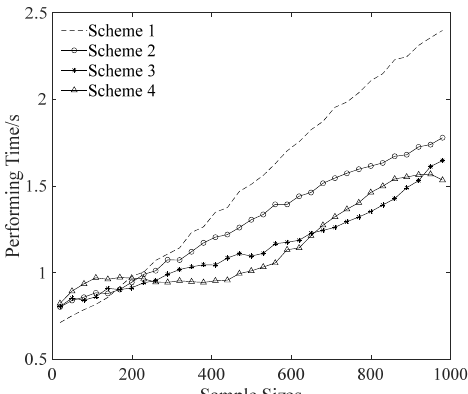
Figure 6. Performing time of each scheme under different total sample sizes on the MCU platform.